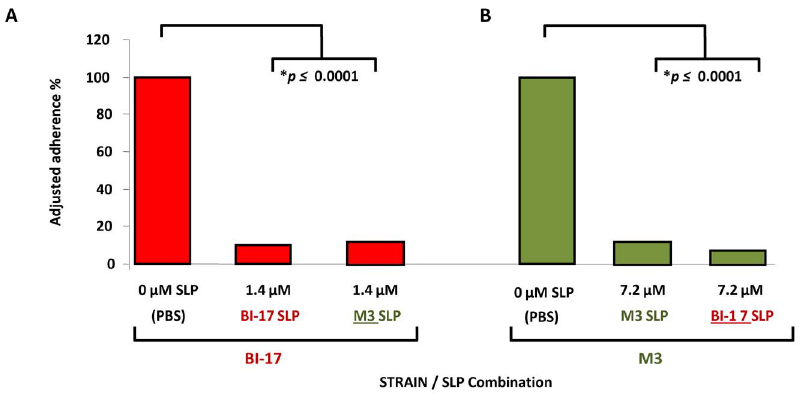
Figure 7. Surface-layer protein (SLP) preparations inhibit attachment of non-cognate C.difficile strains. Panel A (red bars), adherence of epidemic-associated strain BI-17 can be blocked by addition of SLPs extracted from either strain BI-17, or the unrelated non-toxigenic strain M3. Panel B (green bars), adherence of the non-toxigenic strain M3 can be blocked by addition of SLPs extracted from either strain M3, or the unrelated epidemic-associated strain BI-17. All experiments were performed in quadruplicate. For comparative purposes, data were converted to percent adjusted adherence, with adherence of the control (no added antiserum) set to 100%; therefore no error bars appear. Asterisks indicate significant differences ( p # 0.01).